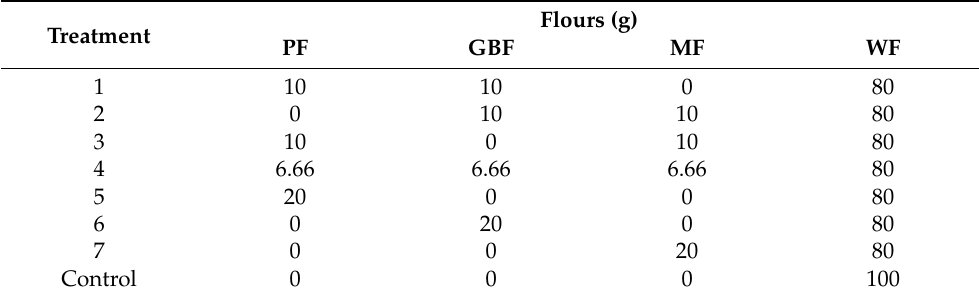
Table 1. Treatments for bread elaboration according to a simplex-centroid design with four differ- ent components.